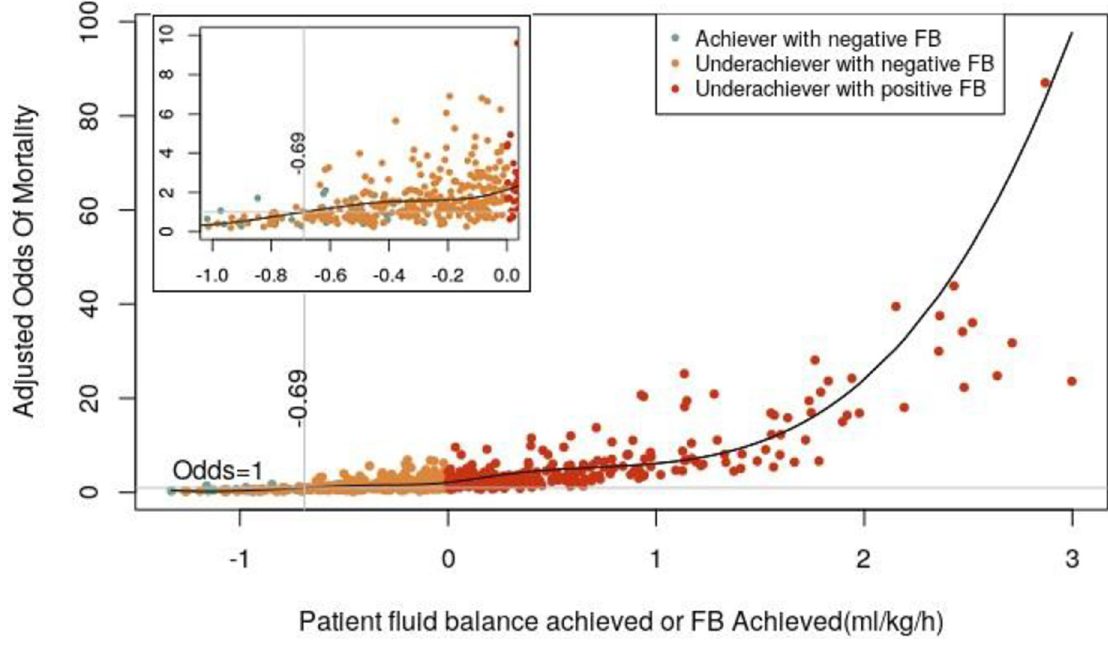
Fig 6. Restricted cubic splines representing the adjusted relationship of FB Achieved (ml/kg/h) with hospital mortality according to final multivariable models. Note that mortality in some patients with negative FB may be influenced by other factors beyond FB Achieved and covariates in the model as depicted by the zoomed portion of the